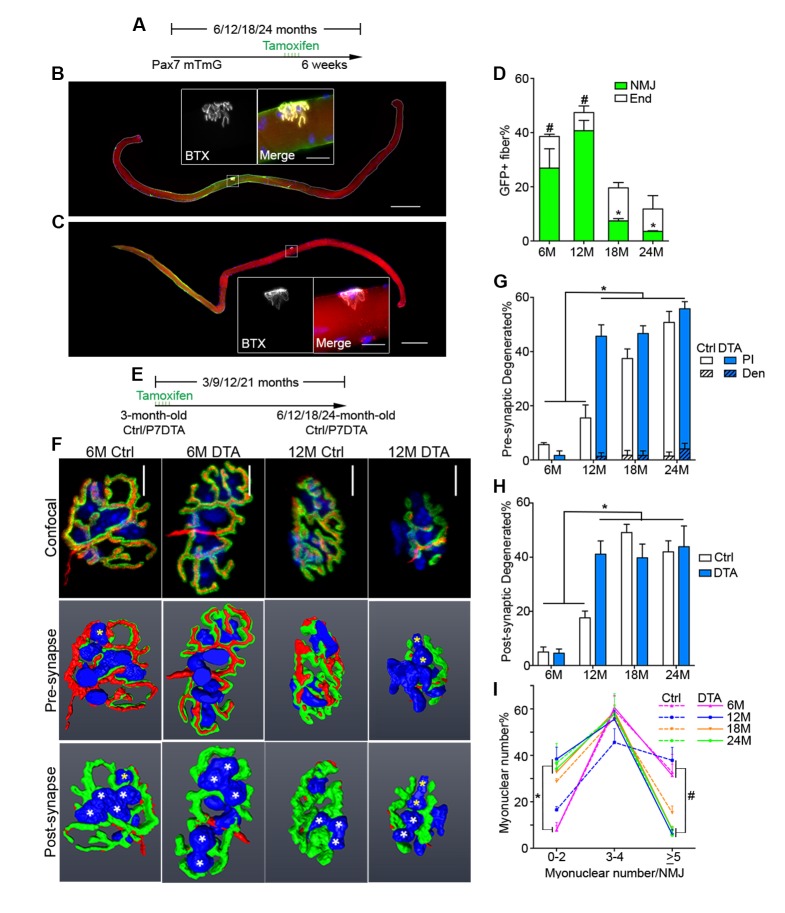
Contribution of SCs to NMJs is lost in aged muscle and SC depletion accelerates age-associated NMJ degeneration.(A) Scheme demonstrating time of tamoxifen treatment and harvest of tissue for P7mTmG mice. (B–C) Representative images of single isolated P7mTmG EDL myofibers from (B) 12-month-old mice, where mGFP is in middle portions where the NMJ is located or (C) 18-month-old mice, where mGFP is located at the end of the fiber. Magnified inset images show NMJs. Scale bar for myofibers = 200 μm, for inset = 25 μm. (D) Quantification of mGFP+ fiber percentage and distribution based on mGFP location (at the end of the fiber or in the vicinity of the NMJ). *p<0.05 for NMJ-associated mGFP compared to 6M/12M groups, #p<0.05 for mGFP at the end compared to NMJ-associated mGFP at that age group, two-way ANOVA/Sidak multiple comparison test. (E) Scheme demonstrating time of tamoxifen treatment and harvest of tissue for Ctrl or P7DTA mice. (F) Confocal IF images and 3-D Amira-based reconstructions (viewed from the pre-synaptic or post-synaptic side) of Ctrl and P7DTA NMJs stained for post-synaptic AChRs (green), nerve terminal markers (red) and nuclei (blue). Post-synaptic myonuclei are indicated with white asterisks, and representative pre-synaptic nuclei indicated with yellow asterisks. Scale bar = 10 μm. (G–H) Quantification of (G) pre-synaptic degenerated, including partially innervated (PI) or completely denervated (Den), or (H) post-synaptic degenerated NMJ percentage of Ctrl and P7DTA TA muscles. *p<0.05, 6M Ctrl/P7DTA, 12M Ctrl vs. 12M P7DTA, 18/24M Ctrl/P7DTA, two-way ANOVA/Sidak multiple comparison test. (I) Percentage distribution of TA NMJs based on number of post-synaptic myonuclei. *p<0.05, 6M Ctrl/P7DTA vs. 12M/18M P7DTA, 24M Ctrl/P7DTA; #p<0.05, 6M Ctrl/P7DTA, 12M Ctrl vs. 12M/18M P7DTA, 24M Ctrl/P7DTA; two-way ANOVA/Sidak multiple comparison test. n = 3 mice per group, ≥50 myofibers examined per mouse (D); n = 3 (18M Ctrl, 24M Ctrl, 24M P7DTA); 4 (6M Ctrl, 6M P7DTA, 18M P7DTA) or 5 (12M Ctrl, 12M P7DTA) mice, >20 NMJs/mouse (G–I).